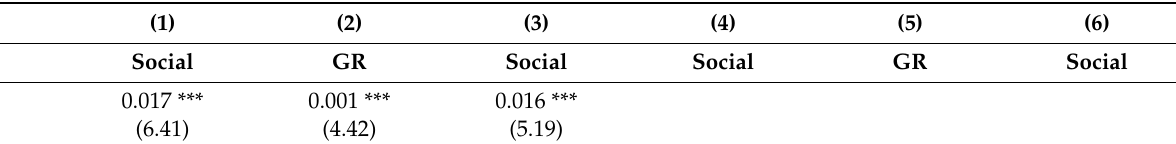
Table 9. Sensitivity test of the dependent